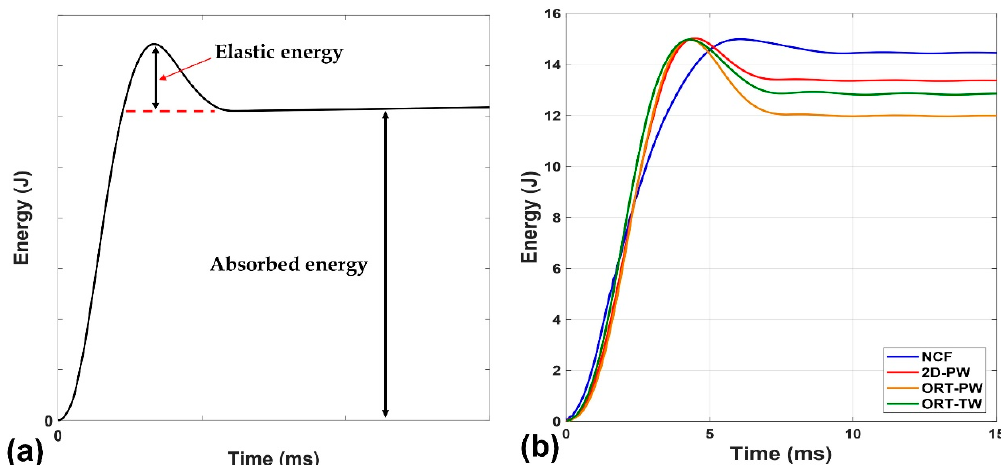
Figure 5. Energy versus time: ( a ) schematic explaining the elastic and absorbed component and ( b ) representative sample for each architecture.